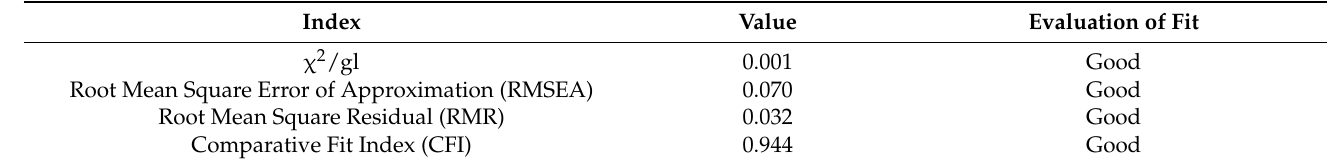
Table 1. Overall model fit indices.